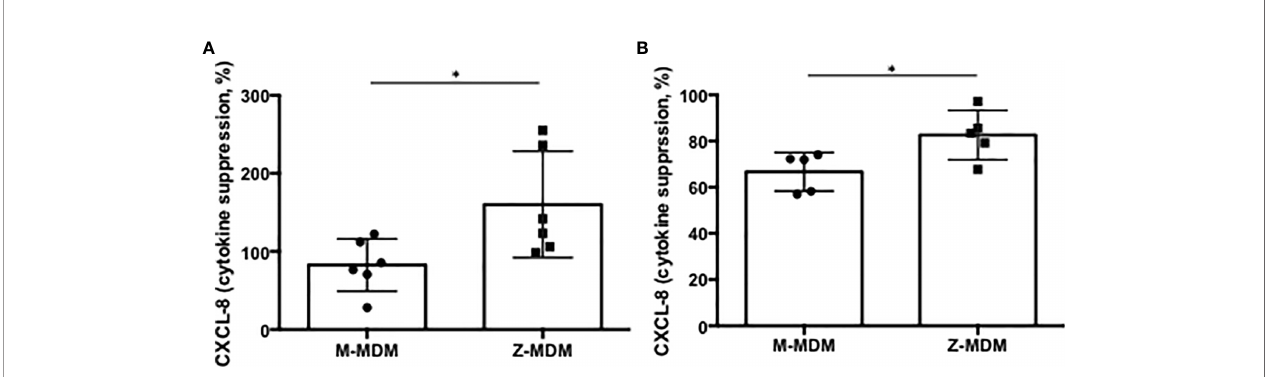
FIGURE 8 | Cytokine suppression in post-efferocytotic macrophages. LPS (10 ng/ml)-stimulated MDMs were incubated with apoptotic (A) neutrophils (n=6) or (B) Jurkat cells (n=5) for 3 h. Then, the expression level of CXCL-8 was compared between control and post-efferocytotic cells. Data are expressed as mRNA levels relative to control which are set to 100%. *Denotes statistical signi fi cance (p-value < 0.05) according to two-tailed Student ’